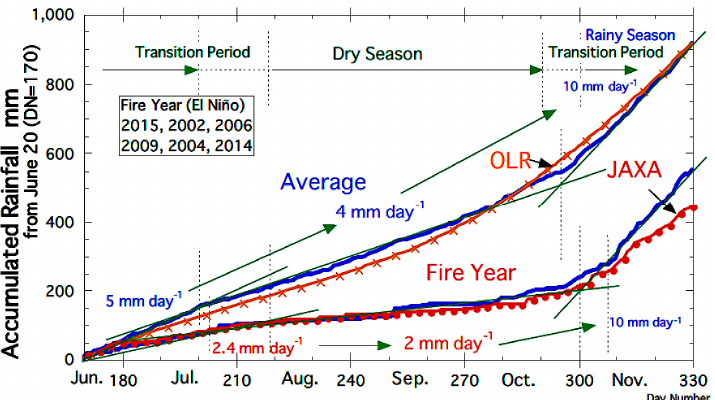
Figure 6. Averaged rainfall trend and fire year trend. Averaged and fire year rainfall data from TRMS. Estimated averaged rainfall data from OLR. Fire year rainfall data from JAXA.